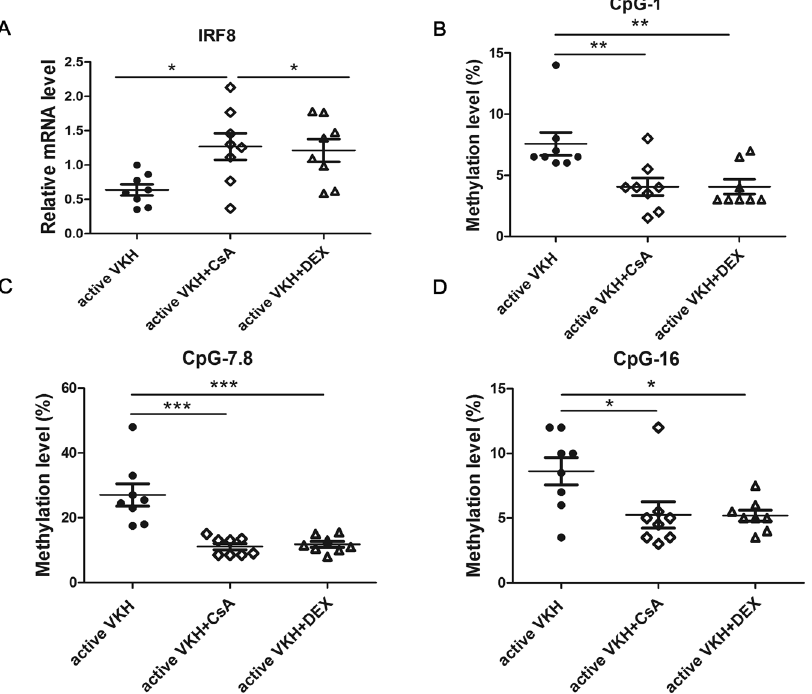
Figure 3. CsA and DEX treatment affects the methylation change and mRNA expression of IRF8 in active VKH patients. ( A ) The mRNA expression of IRF8 was detected by real-time PCR in DCs with or without the treatment with CsA or DEX. DCs were obtained from active VKH patients (n = 8, * p < 0.05). The methylation changes shown in CpG_1 ( B ), CpG_7.8 ( C ) and CpG_16 ( D ) of CsA treated and DEX treated DCs were significantly decreased compared to the untreated DCs from active VKH patients (n = 8, * p < 0.05, ** p < 0.01, *** p < 0.001). The data are shown as mean ± SEM. One way-ANOVA, followed by Bonferroni correction was used to compare the mRNA level and methylation changes among multiple